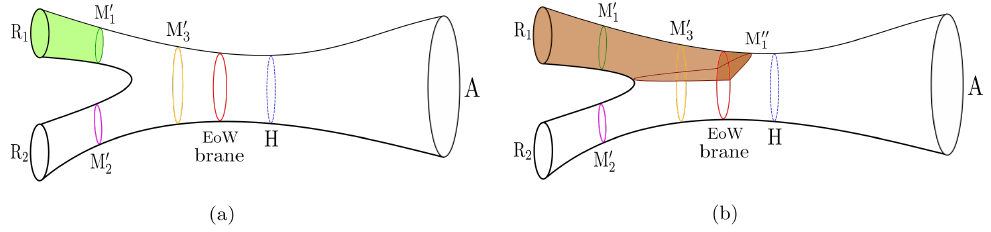
Figure 3. Entanglement wedge of radiation subsystem R 1 (a) before and (b) after Page time. (a) The green shaded region is the EW of R 1 as M 0 is the preferred RT surface. (b) At Page time, the 1 RT surface of R 1 changes to M 00 (marked as brown), which goes through the EoW brane (red) and 1 partially contains the interior of the real black hole. The EW of R 1 after Page time is shown by the brown shaded region, which includes a part of the island marked by the deeper brown colour. Here the blued dotted circle denotes the RT surface of the real black hole. M 0 and M 0 denote the RT 2 3 surface of radiation subsystem R 2 and R 1 ∪ R 2 before Page time